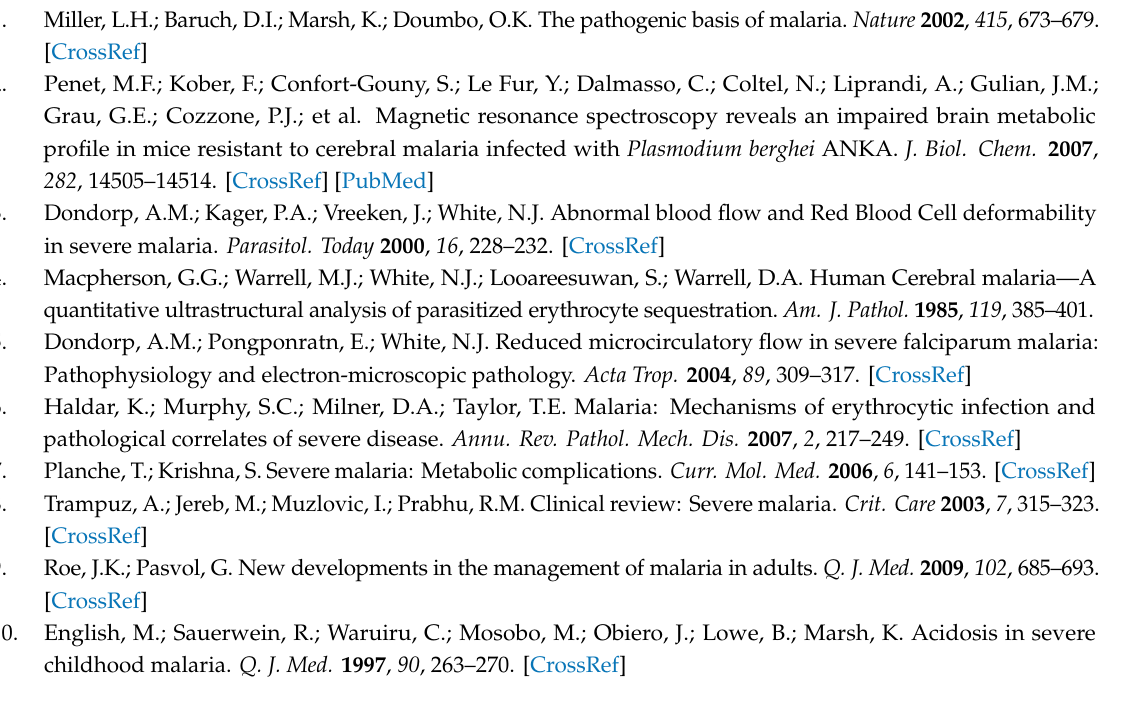
Table S1: 13C chemical shifts of significant loadings from liver OPLS-DA analysis. The chemical shifts were putatively identified using human metabolome database